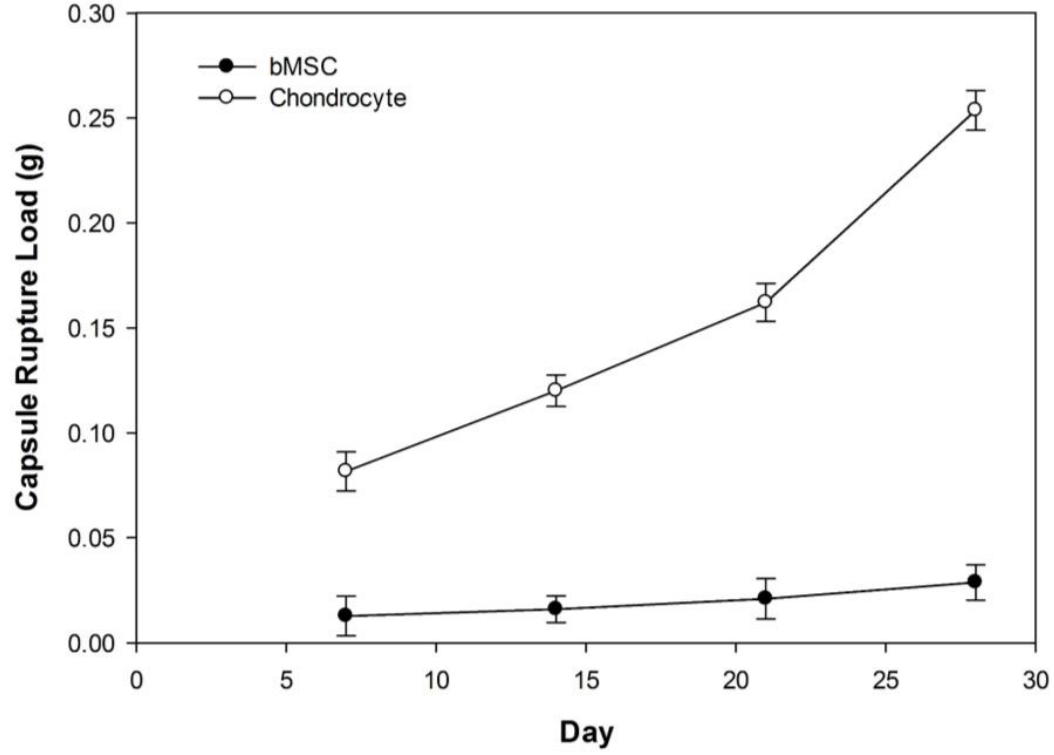
Figure 10. The 28-day encapsulation culture PECM rupture strength analysis. Error bars indicate standard deviation.